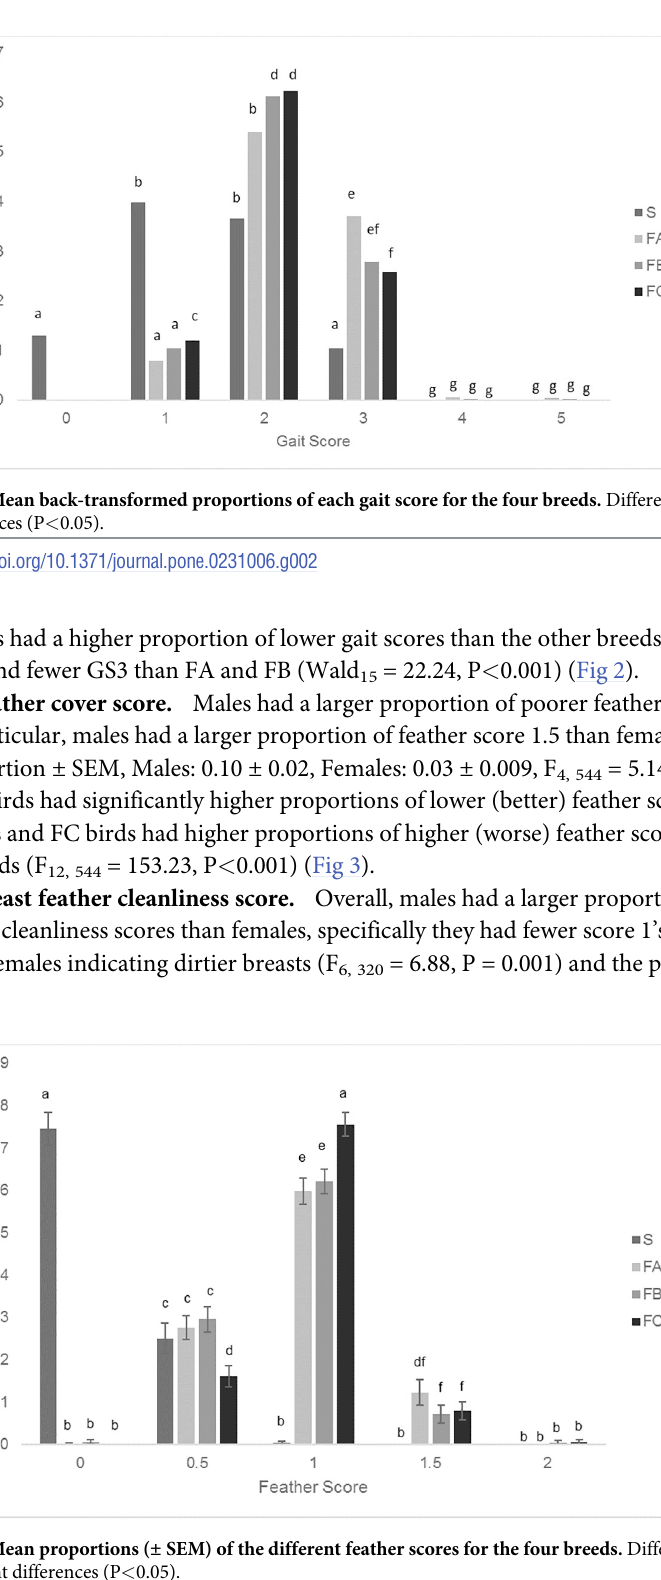
Fig 3. Mean proportions ( ± SEM) of the different feather scores for the four breeds. Different letters denote signicant differences (P < 0.05).